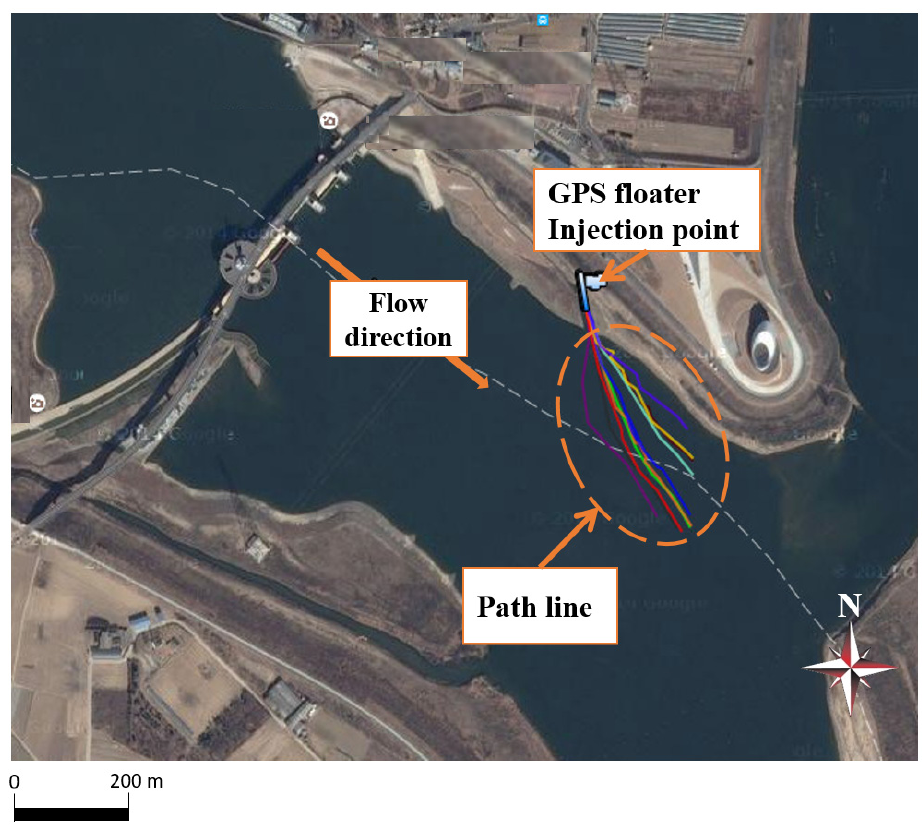
Figure 5. Path lines acquired from GPS drifter field experiments. Excluding two GPS drifters with overlapping path lines, the average flow velocity of the remaining 8 GPS drifters in the pre-determined section (Track 1–Track 8; velocity range: 0.0563–0.0870 m/s) was calculated. Results are shown in Table 2. River2D sim- ulation was run under the same conditions as those in the field experiment, i.e., water discharged into the by-pass fishway only without operating the movable wire. Results of comparison between the in situ experiment data and numerical simulation data under the same boundary conditions are shown in Figure 6. The coefficient of determination (R 2 ) and the root-mean-square error (RMSE) were 0.9221 and 0.000026, respectively. Thus, results of River2D simulation demonstrated high reliability. Table 2. The average velocity calculated from GPS drifter